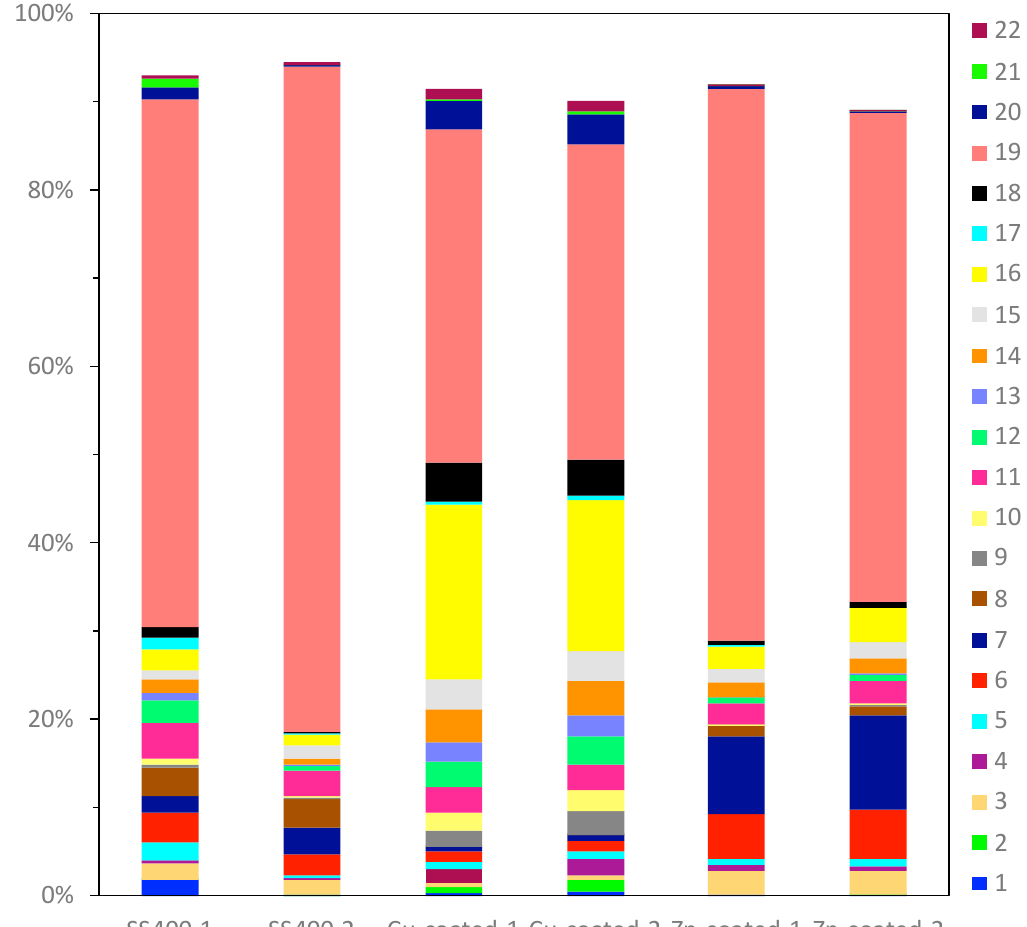
Figure 17. The OTU abundance percentages on water-immersed coupons. Bacterial orders present at <1.0% and unassigned OTUs are excluded from each column. (1) Solibacterales; (2) PK29; (3) Actinomycetales; (4) Cytophagales; (5) Saprospirales; (6) MLE1-12; (7) Stramenopiles; (8) Clostridiales; (9) Gemmatales; (10) Pirellulales; (11) Caulobacterales; (12) Rhizobiales; (13) Rhodobacterales; (14) Rhodospirillales; (15) Rickettsiales; (16) Sphingomonadales; (17) Unknown member of Betaproteobacteria; (18) Burkholderiales; (19) Rhodocyclales; (20) Myxococcales; (21) Unknown member of VHS-B5-50; (22) Unknown member of SJA-4. Table 3. The OTU percentages of order Sphingomonadales on post LBR-immersed coupons. Table 2. The OTU percentages of order Rhodocyclales on post LBR-immersed coupons. All assigned Family genera are from the family Rhodocyclaceae. Sphingomonadaceae Azoarcus